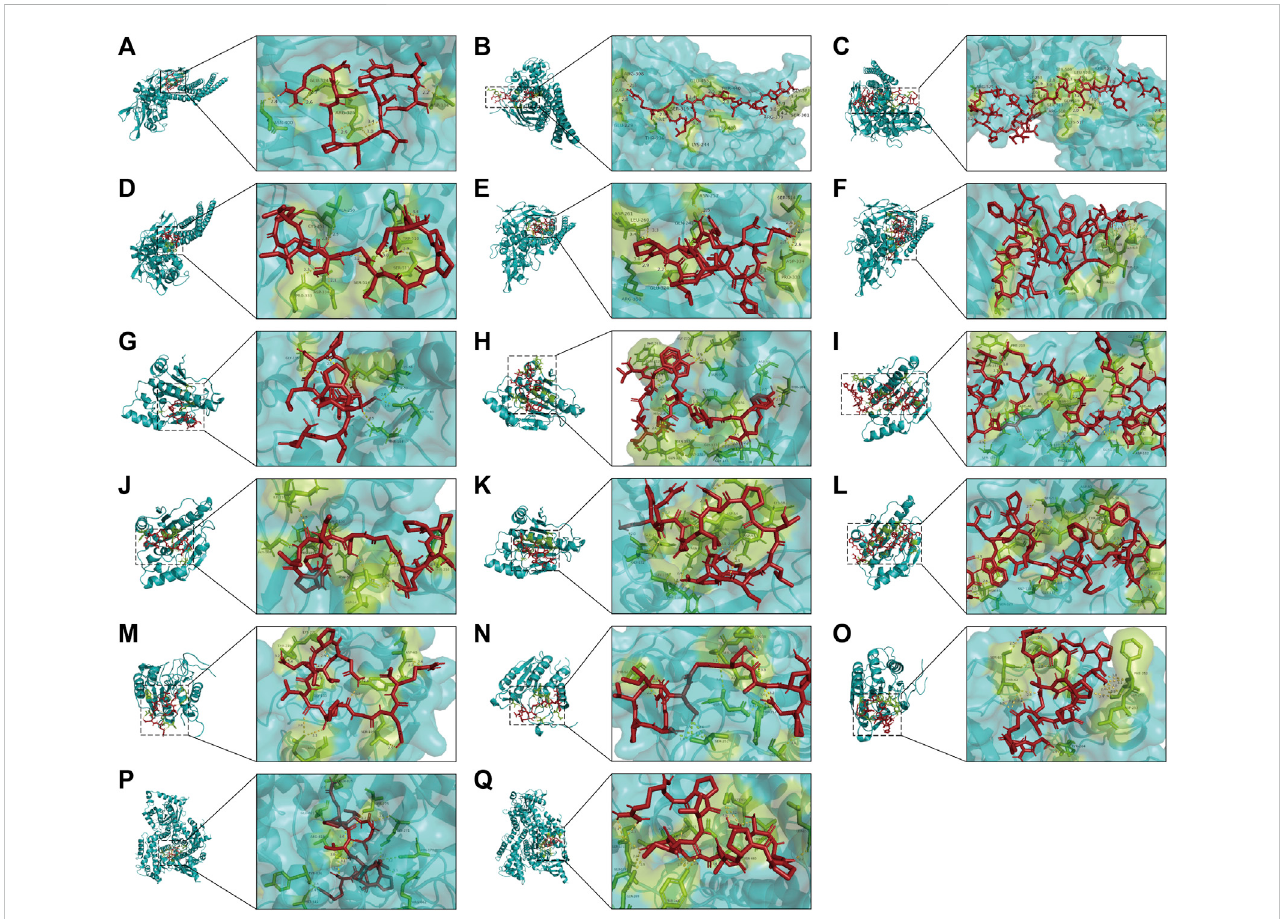
FIGURE 9 Diagram of the molecular docking pattern. (A) 1-STAT3; (B) 2-STAT3; (C) 4-STAT3; (D) 5-STAT3; (E) 6-STAT3; (F) 7-STAT3; (G) 1-HSP90AA1; (H) 3- HSP90AA1; (I) 4-HSP90AA1; (J) 5-HSP90AA1; (K) 6- HSP90AA1; (L) 7-HSP90AA1; (M) 1-CASP3; (N) 5-CASP3; (O) 6-CASP3; (P) 1-PIK3CA; (Q) 5-PIK3CA. Blue represents the protein; green represents the bioactive peptide binding site to the protein; red represents the active